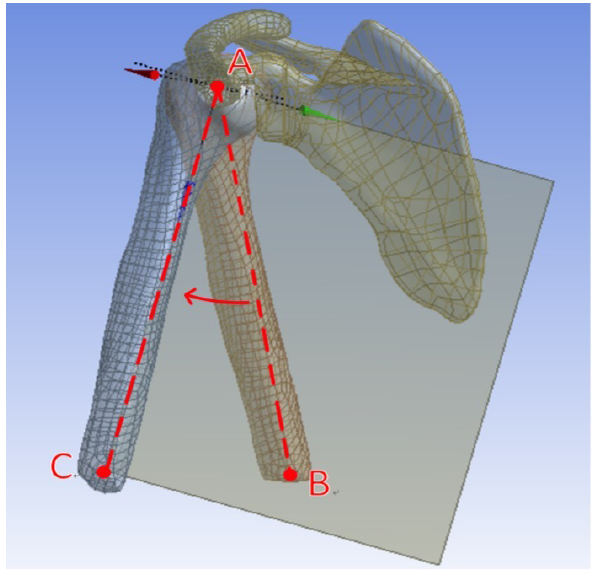
Fig. 2. Model establishment of the recurve bow characteristic actions.